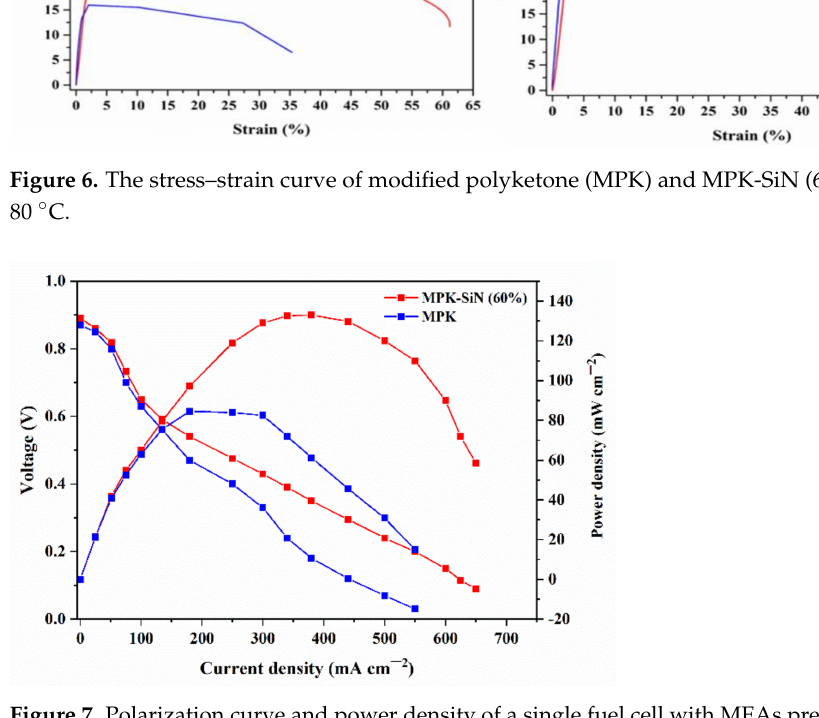
Figure 7. Polarization curve and power density of a single fuel cell with MEAs prepared using MPK and MPK–SiN (60%) membranes at 80 ◦